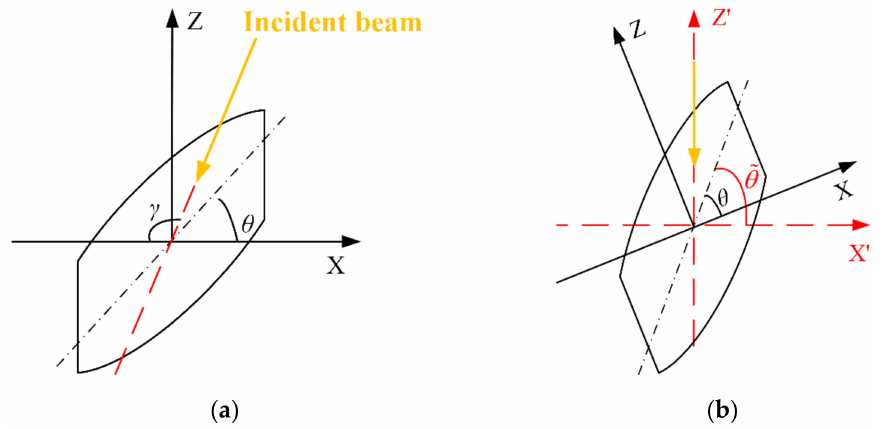
Figure 7. Method to deal with the beam incident from any direction: ( a ) Beam incident from any direction; ( b ) any direction is equivalent to the normal incident beam after